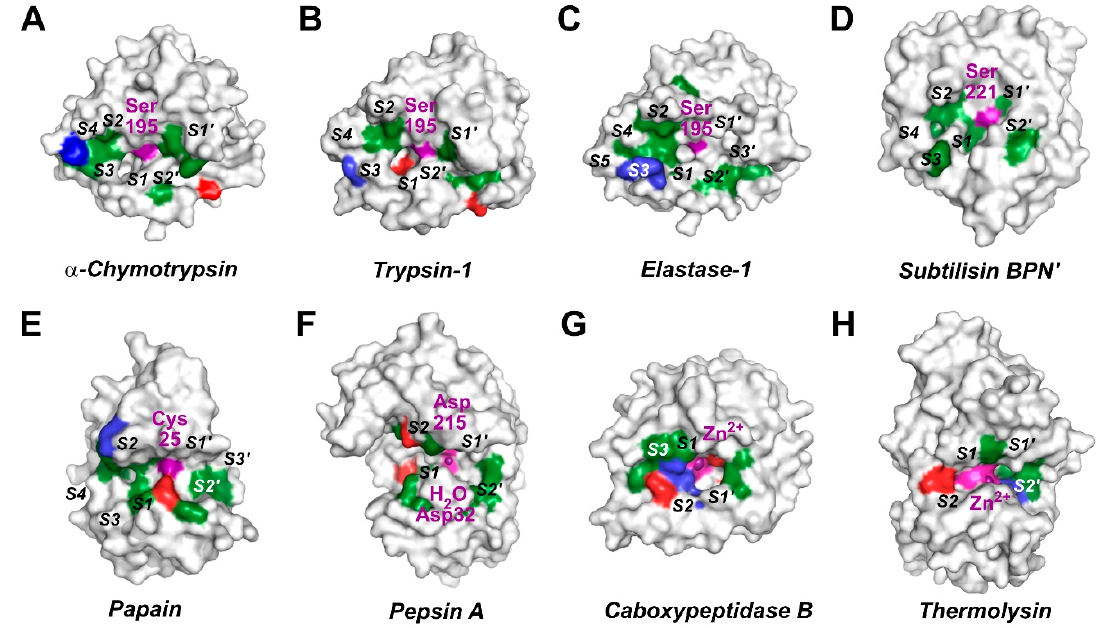
Figure 3. Proteases as ligases. Molecular surfaces are depicted white in overall polar and hydrophilic regions. Positively (blue) and negatively (red) charged residues, as well as hydrophobic patches (green) contributing to the specificity are colored. Crucial catalytic residues and ions (purple) are labeled, including catalytic water molecules (magenta), as well as the most relevant specificity pockets. All proteases are shown in the standard orientation, with the N-terminus of the substrate to the left and the C-terminus on the right. ( A ) Bovine α -chymotrypsin. ( B ) Bovine β -trypsin. ( C ) Porcine pancreatic elastase 1. ( D ) Bacterial subtilisin BPN (cid:48) ; from Bacillus ameloliquefaciens . ( E ) The plant cysteine protease papain. ( F ) The aspartic protease porcine pepsin. ( G ) Porcine carboxypeptidase B. ( H ) Thermolysin from the bacterium Bacillus thermoproteolyticus